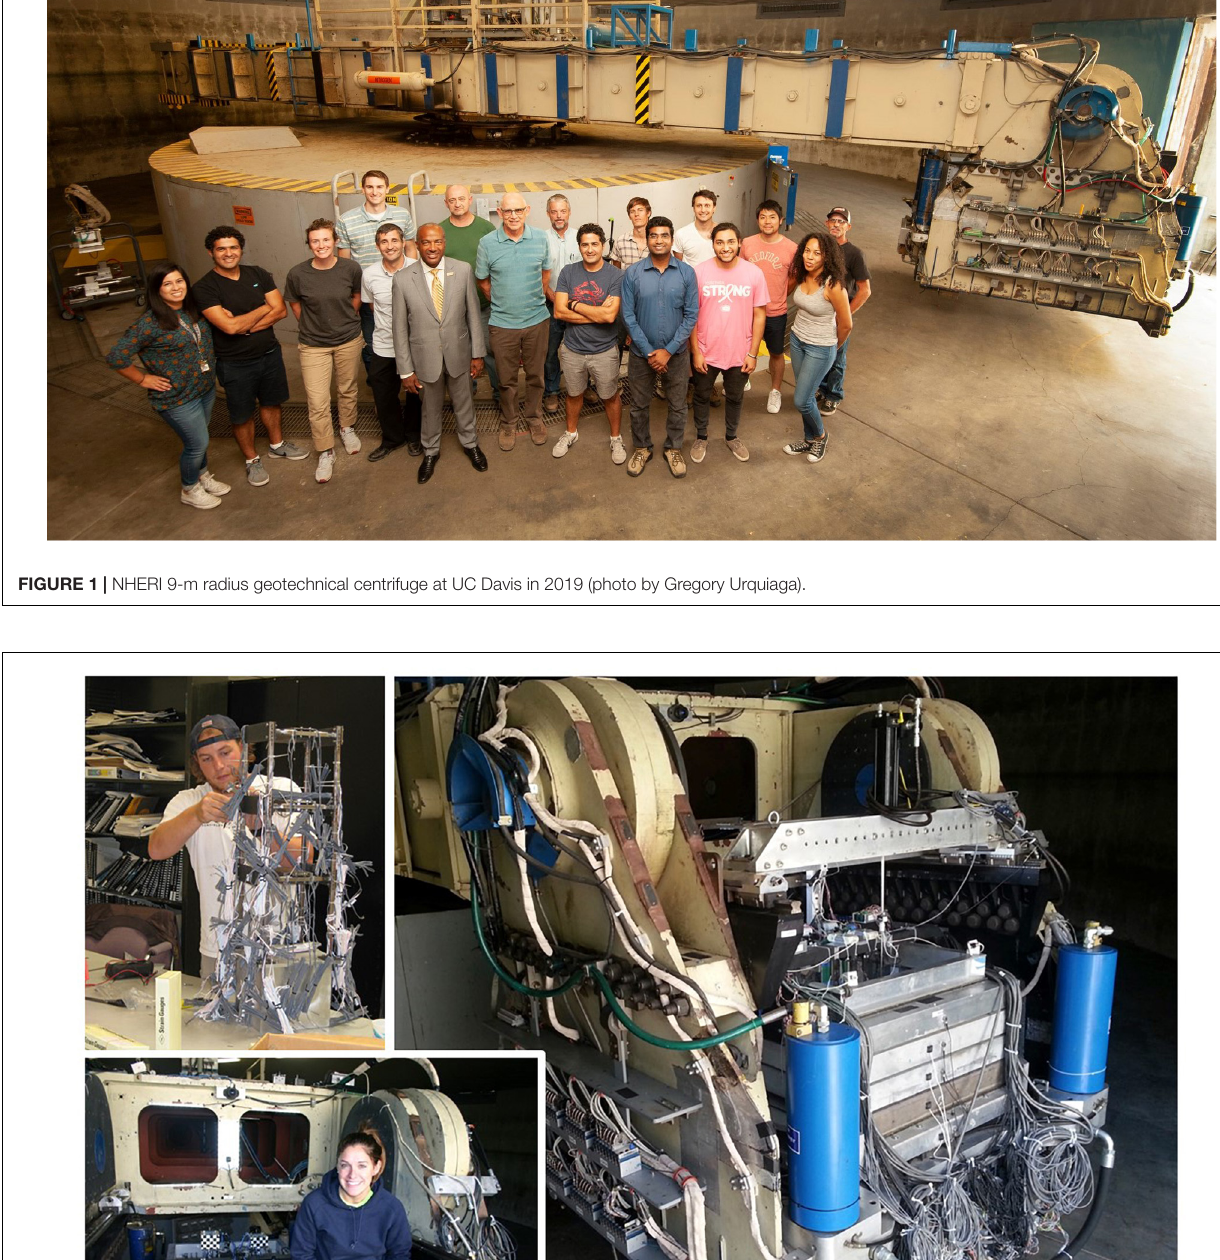
Frontiers in Built Environment |